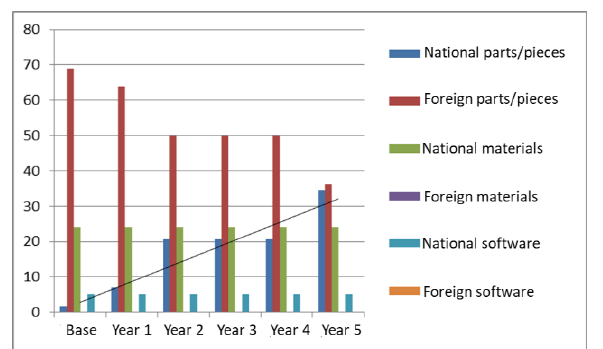
Fig. 9. Distribution by group at 5